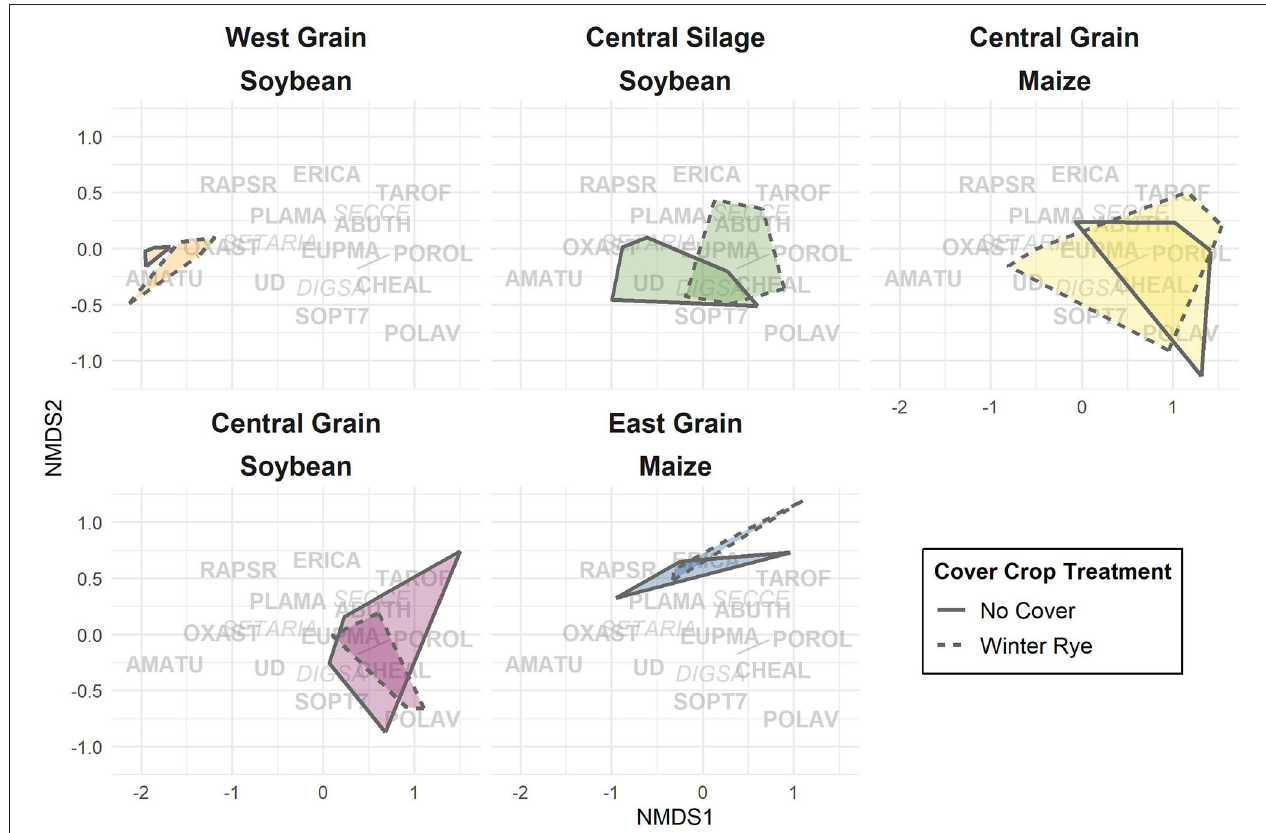
FIGURE 3 | Non-metric multidimensional scaling (NMDS, stress = 0.102) applied to weed seedbank communities. Overlap of regions indicates degree of similarity between communities. Text represents Bayer weed codes (italics: monocots, bold: dicots; Table 3 ) and their NMDS component weightings. Trials are separated for ease of viewing.